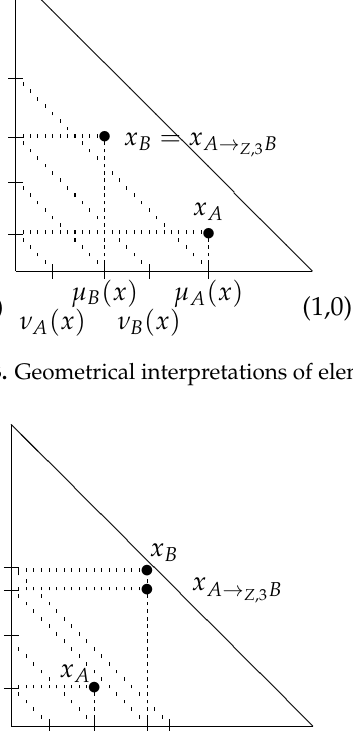
Fig. 4: Geometrical interpretations of elements x A , x B and x A